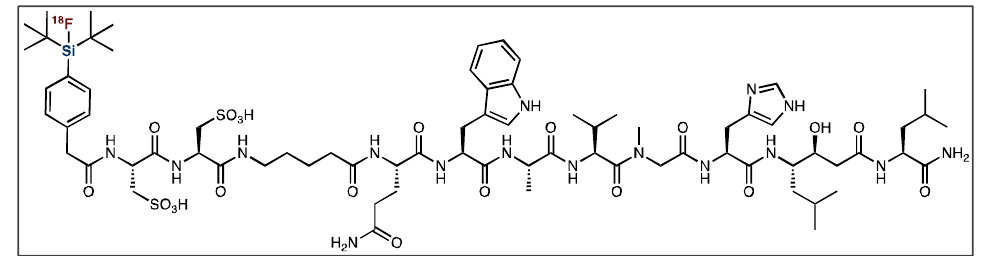
Figure 11. General structure of [ 18 F]SiFA bombesin derivative.